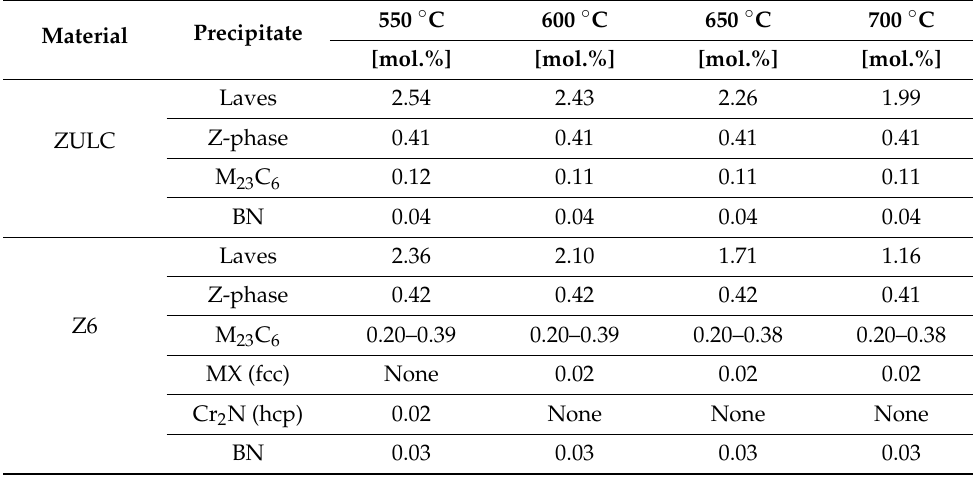
Table 7. Calculated equilibrium phase fraction in mol.% for ZULC and